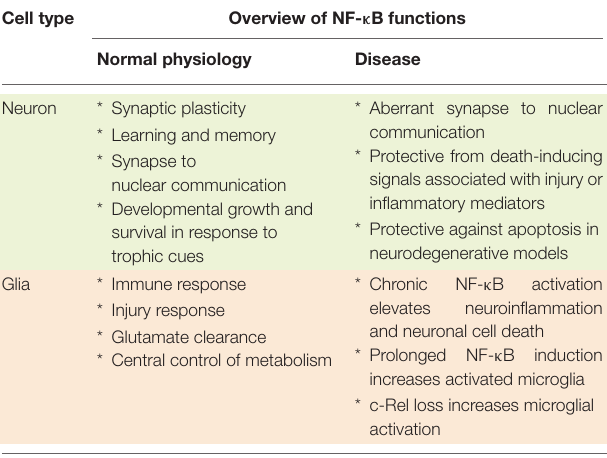
TABLE 1 | Summary of NF- κ B roles in neurons and glia, both in normal physiology and